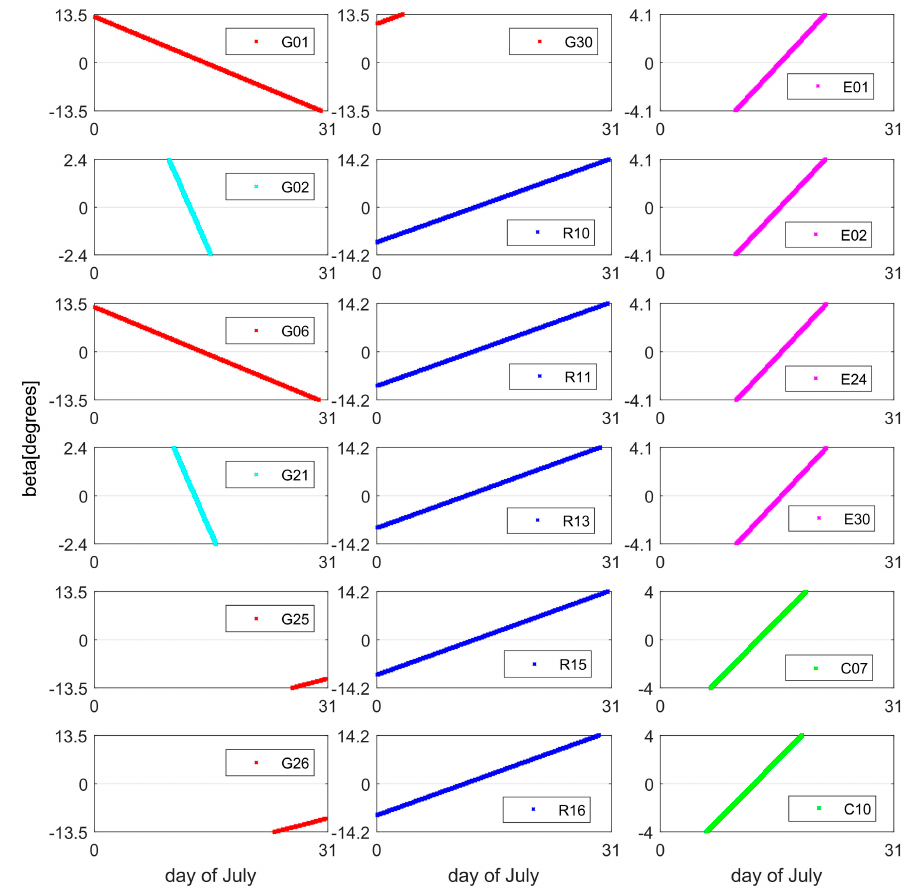
Figure 1. The monitoring results of the eclipsing satellites in July 2017.